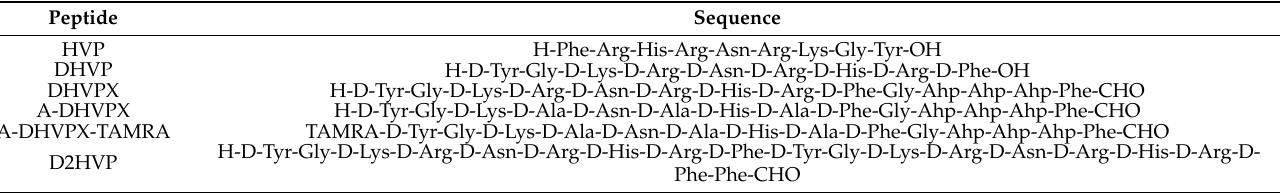
Table 1. Peptide